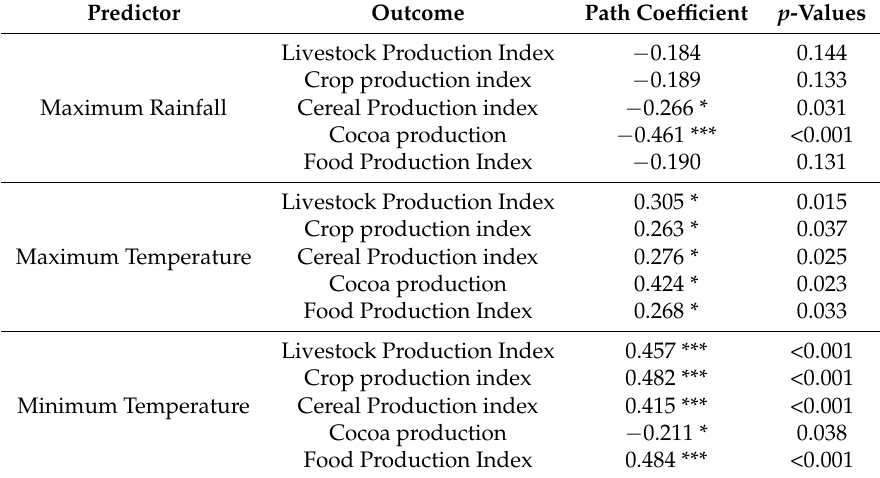
Table 8. Standardised Regression Weights and significance of